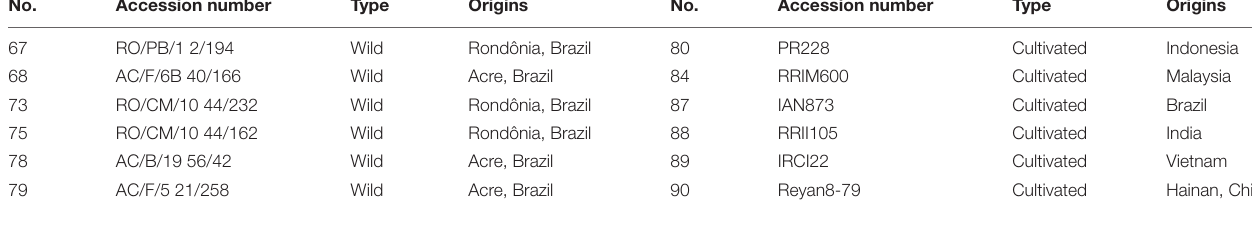
TABLE 1 | Summary of the cultivated and wild rubber tree germplasms in this study. No.